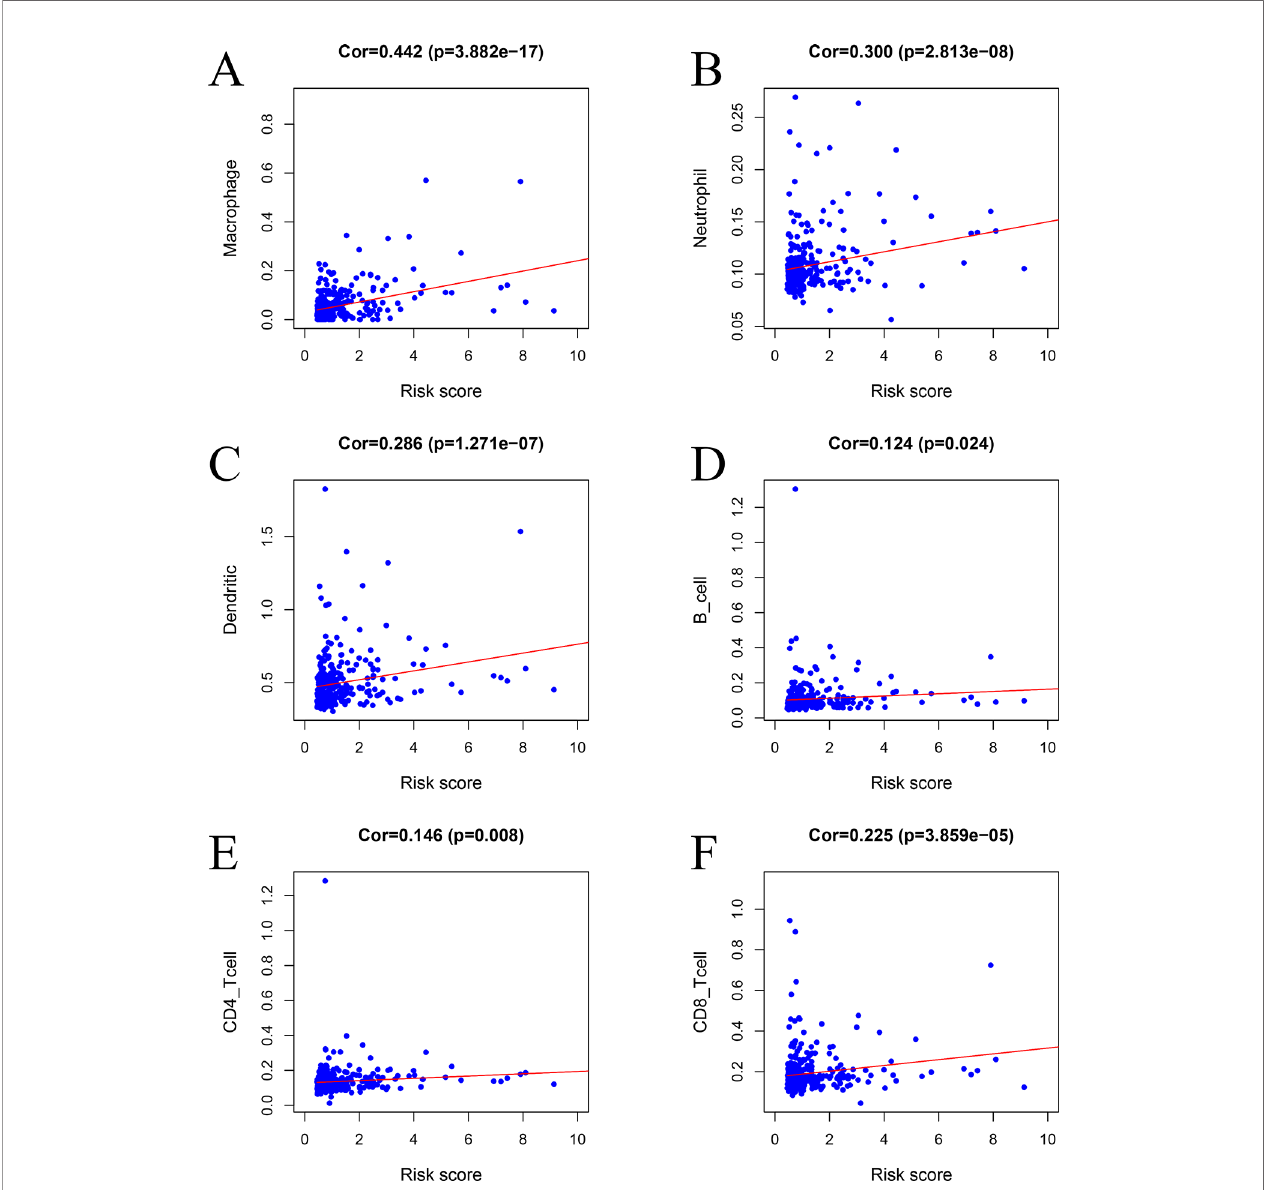
FIGURE 11 | Relationships between the prognostic model and immune cell in fi ltration: (A) macrophages, (B) neutrophils, (C) dendritic cells, (D) B cells, (E) CD4 T cells, and (F) CD8 T